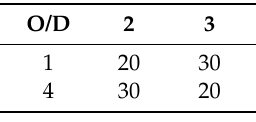
Table 5. Equilibrium link flow.